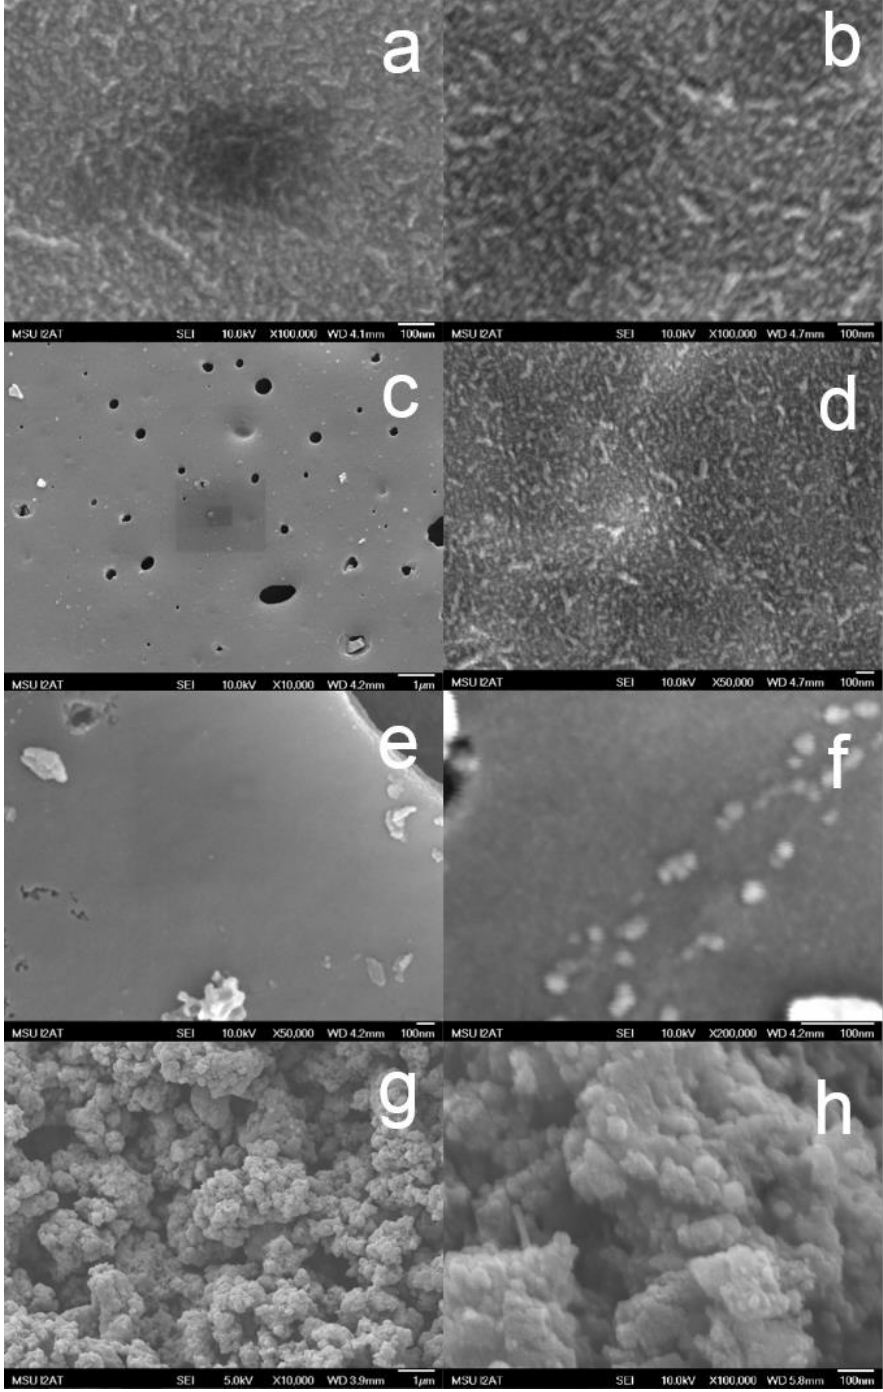
Figure 5. Scanning electron microscope images of four iron source (iron(II) sulfate ( a , b ) iron(II) chloride ( c , d ), iron(III) chloride ( e , f ) and iron nitrate ( g , h )) promoted kraft lignin samples thermally treated at 1000 °C for 1 h under an argon flow.